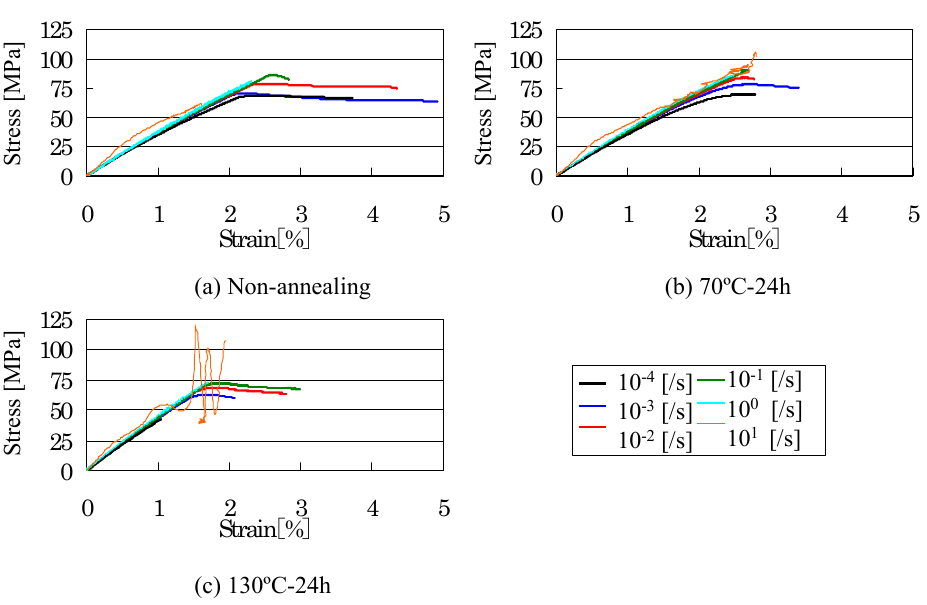
Figure 2 Tensile stress-strain curves of PLLA specimens with strain rates.